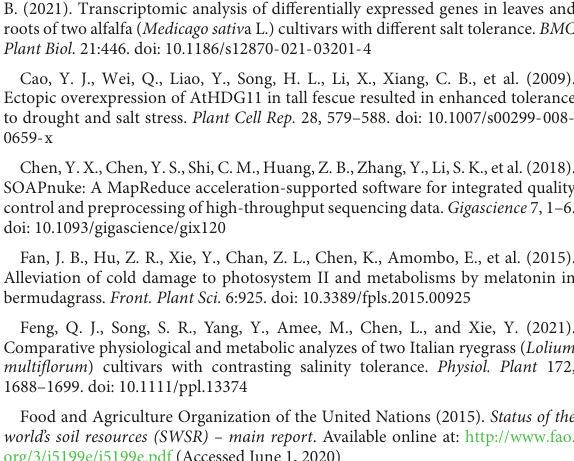
SUPPLEMENTARYFIGURE1 Growth of tall fescue after 10 days of 24-epibrassinolide and salt stress treatments. SUPPLEMENTARYFIGURE2 A bidirectional clustering heatmap of DEGs in the SALT vs. SE comparison. SUPPLEMENTARYFIGURE3 Plant hormone signal transduction in SALT vs. SE comparison. SUPPLEMENTARYFIGURE4 FPKM values of genes used for qRT-PCR analysis. (A) FPKM values of Unigene30391; (B) FPKM values of CL2028.Contig1; (C) FPKM values of CL1847.Contig5; (D) FPKM values of CL1052.Contig9; (E) FPKM values of Unigene4922; (F) FPKM values of Unigene7275; (G) FPKM values of CL1002.Contig34; (H) FPKM values of